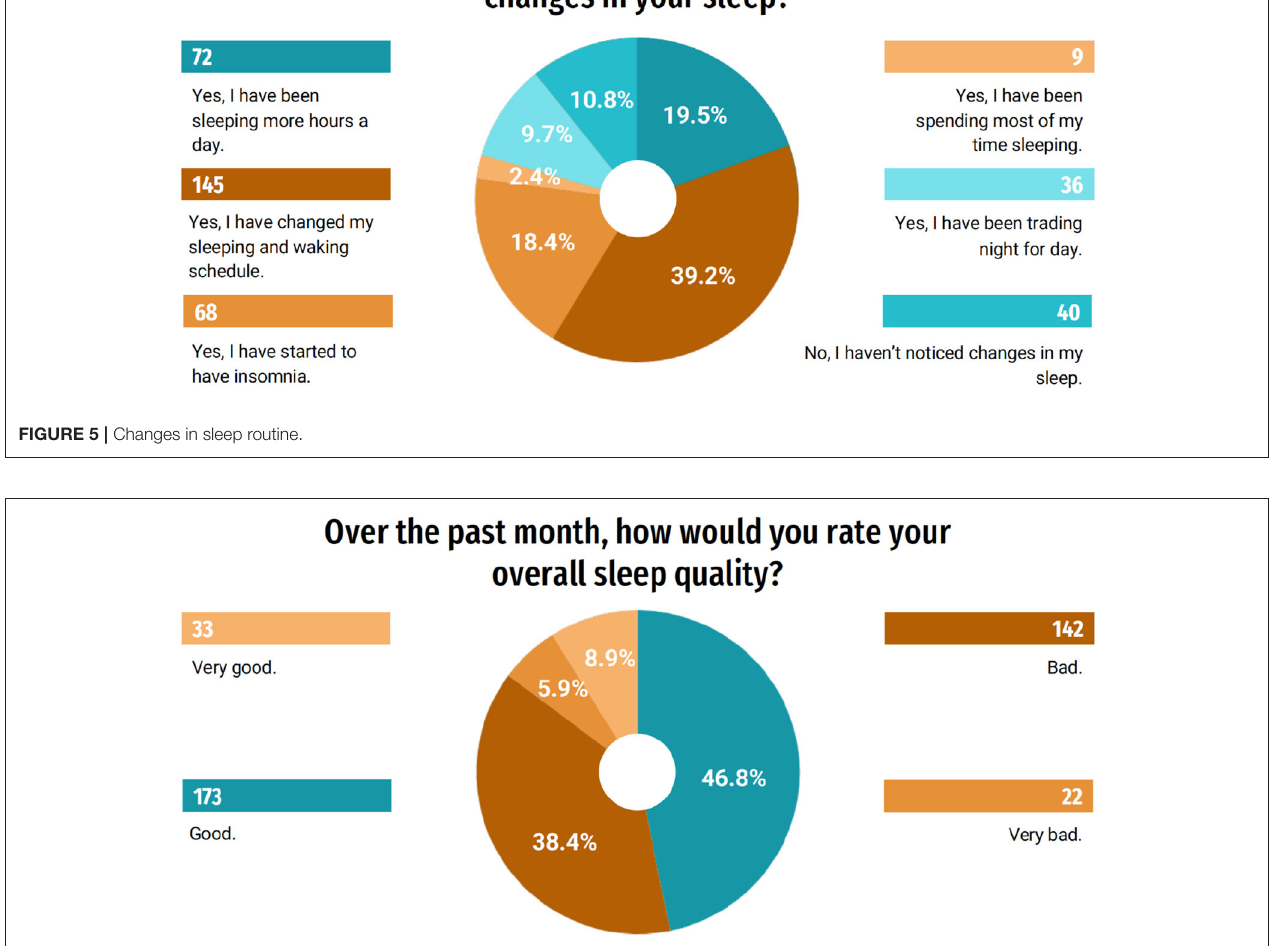
FIGURE 6 | Quality of